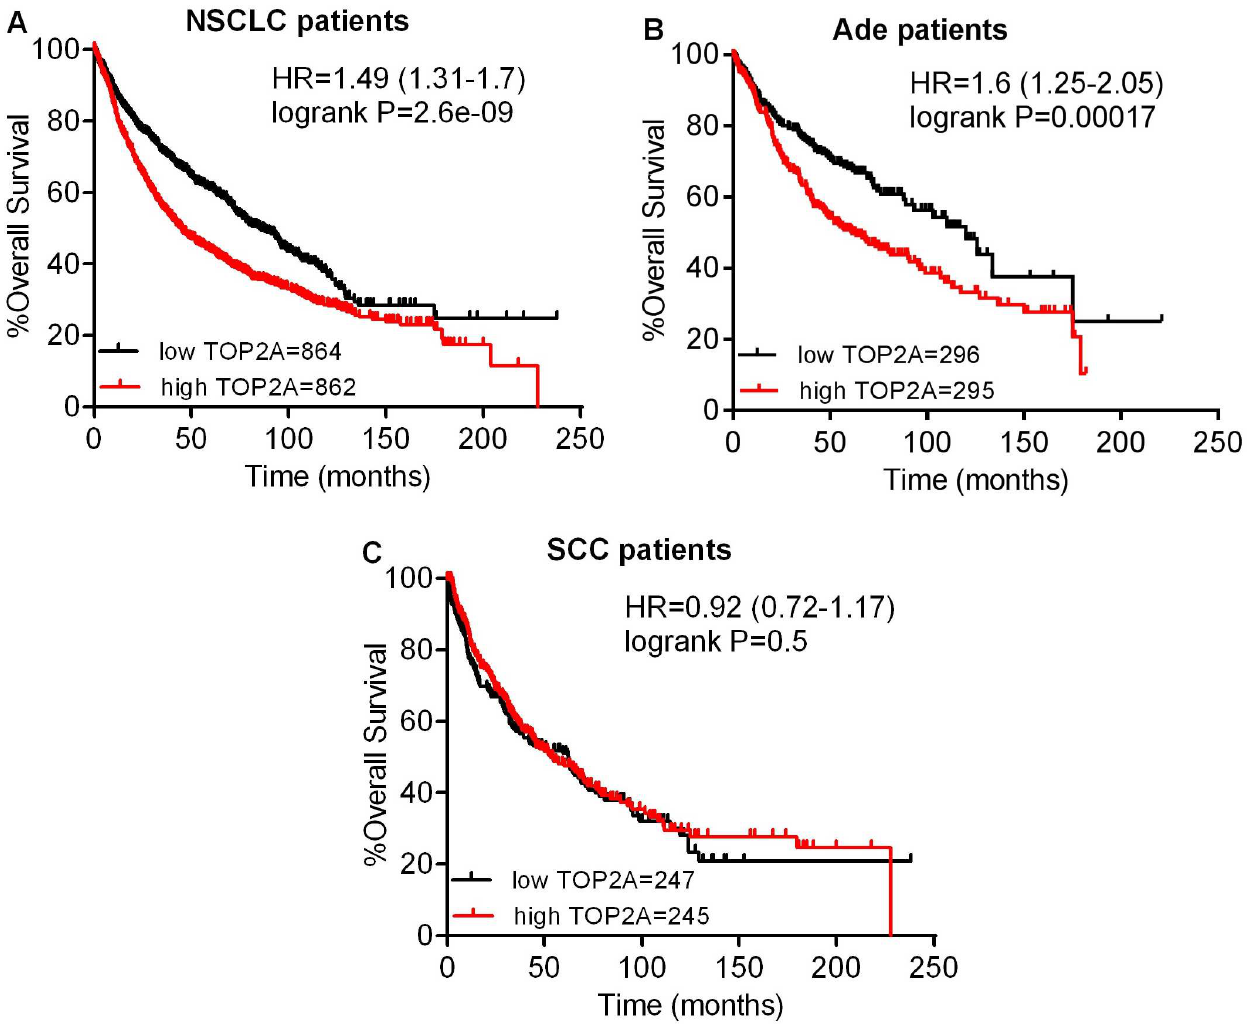
Fig 4. The prognostic values of TOP2A expression. (A) Survival curves were plotted for all NSCLC patients (n = 1726). (B) Survival curves were plotted for Ade patients (n = 591). (C) Survival curves were plotted for SCC patients (n = 492). Data was analyzedusing Kaplan-Meier Plotter. Patients with expressionabove the median are indicatedin red line, and patients with expressions belowthe medianin black line. HR means hazardratio.